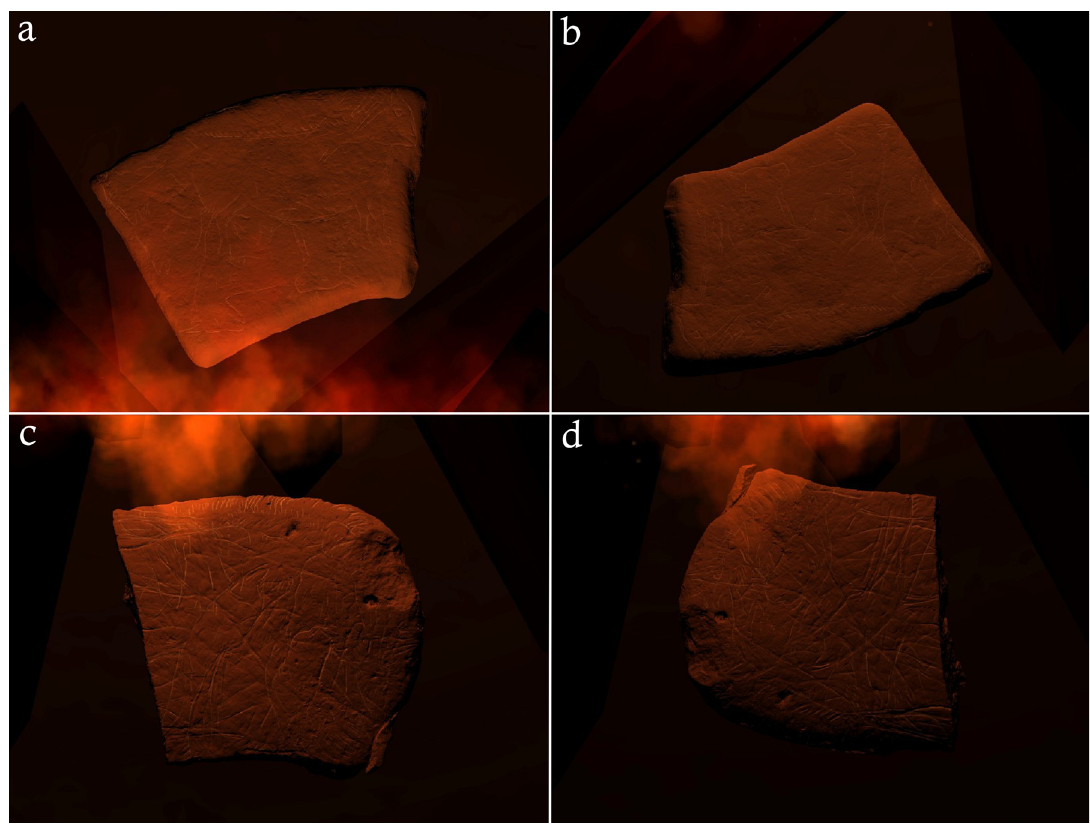
Fig 7. High resolution screen captures of the 3D models of plaquettes 662 (a, b) and 685 (c, d) from Montastruc in the VR lighting simulation. The different position of the viewer or orientation of the plaquette renders visible or ambiguates different figurative depictions on the plaquette. For plaquette 662 one orientation reveals a large ibex (a), and another reveals two ibexes facing each other (b). For plaquette 685, several horse heads can be perceived in one orientation (c) whilst a grazing horse can be seen in another